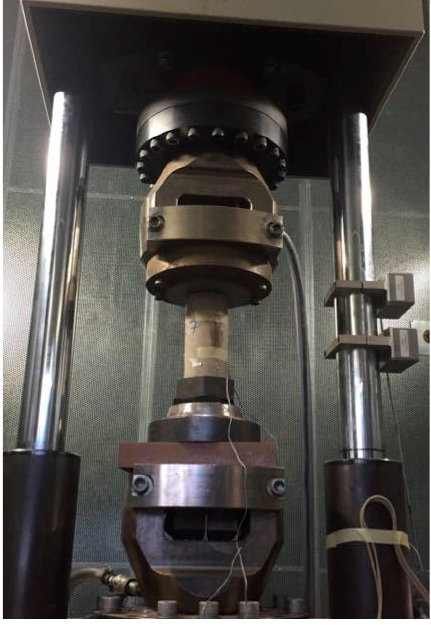
Figure 2. Zwick Amsler 400 HFP 5100 Vibrophore equipment. Schematic diagram of equipment and test specimen.